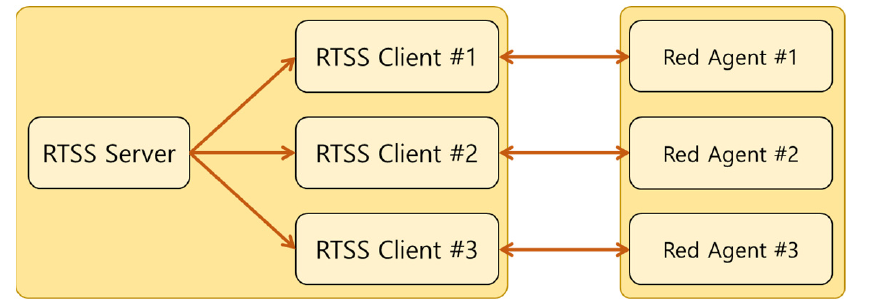
Figure 4. Structure of the whole system.